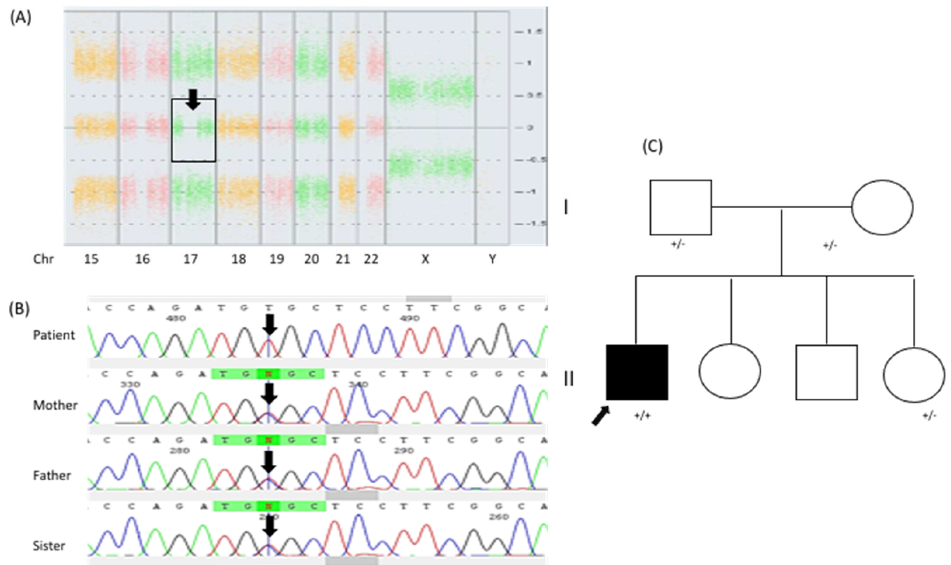
Figure 2. Results of the molecular studies. ( A ) CMA plot showing the 22.78 − Mb ROH at 17q11.1-q21.33 (Chr17: 25,309,336-8,094,611 GRCh37). ( B ) Partial electropherogram of exon 3 of the NAGLU gene, indicating (black arrow) the homozygous pathogenic variant NM_000263.3:c.700C>T or p.(Arg234Cys) in index case II.2, and showing that both parents I.1 and I.2 and the youngest sister II.3 were heterozygous for the variant. ( C ) Two-generation patient’s pedigree.